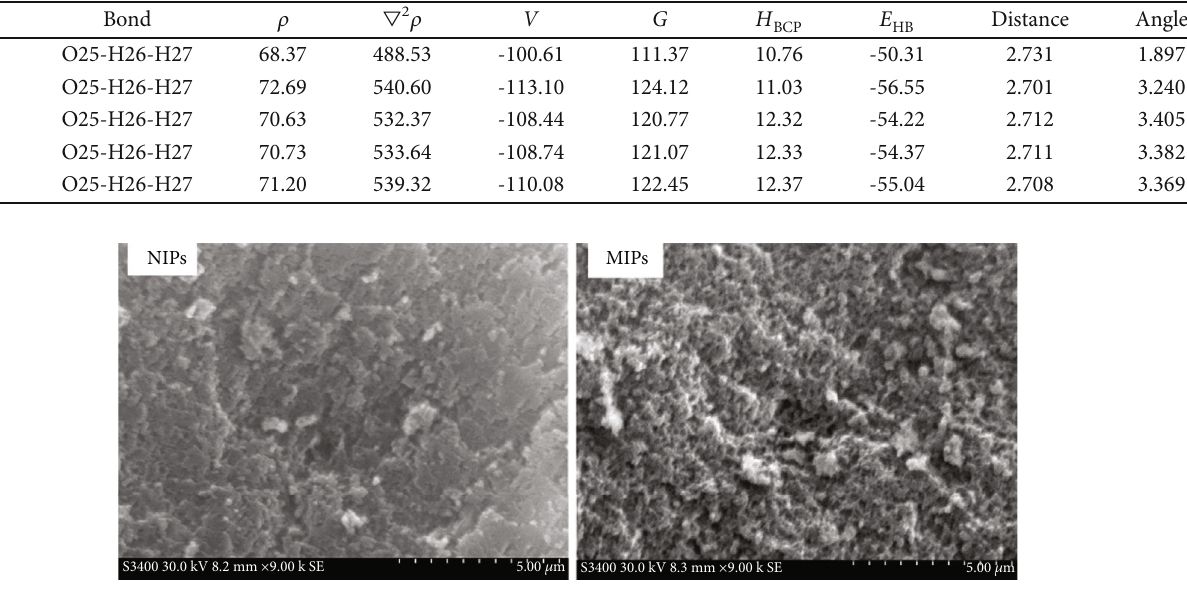
Table 4: The BCP analysis of intramolecular hydrogen bond of ALA-NVCL complex.